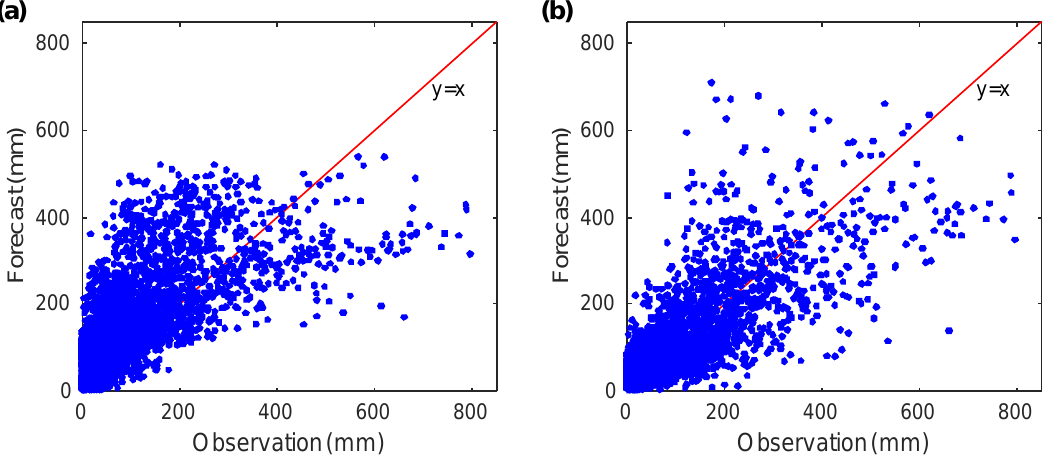
Figure 10. Scatter plots on observation and forecasts of EOF – ARIMA and CSEOF – ARIMA: ( a ) EOF – ARIMA forecasts, ( b ) CSEOF – ARIMA forecasts.